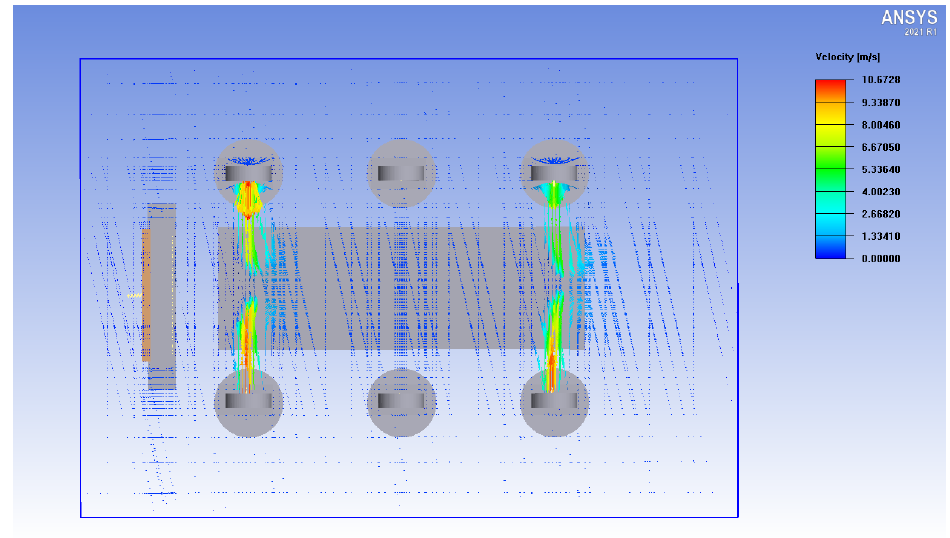
Figure 31. Air purification equipment high-speed simulation results placed in a conference room - 1.